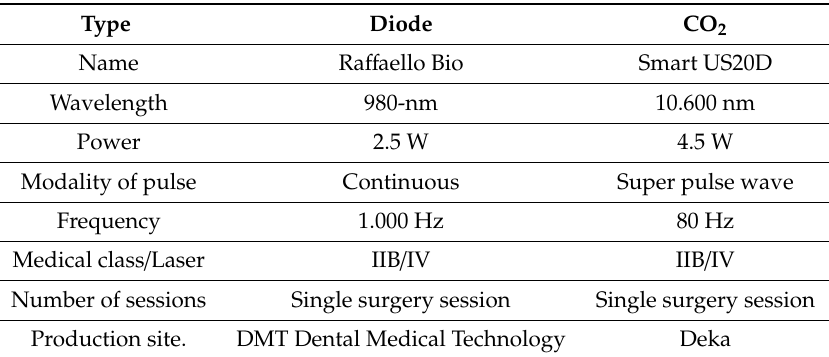
Table 2. Setting of the devices.